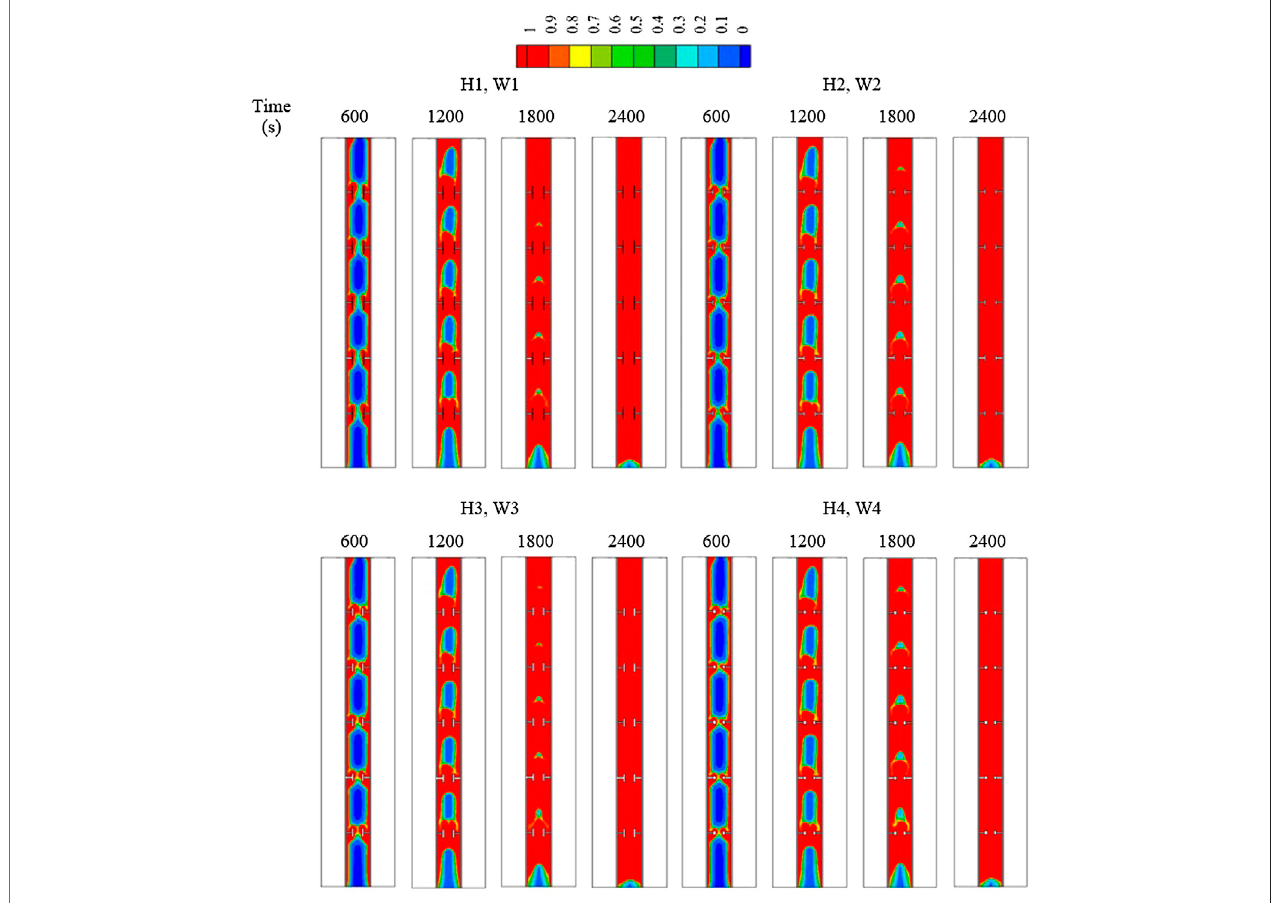
FIGURE 4 | The liquid fraction development for various dimensions of the T-shaped fi ns heads at various times (the sizes of the fi n ’ s body are the same).